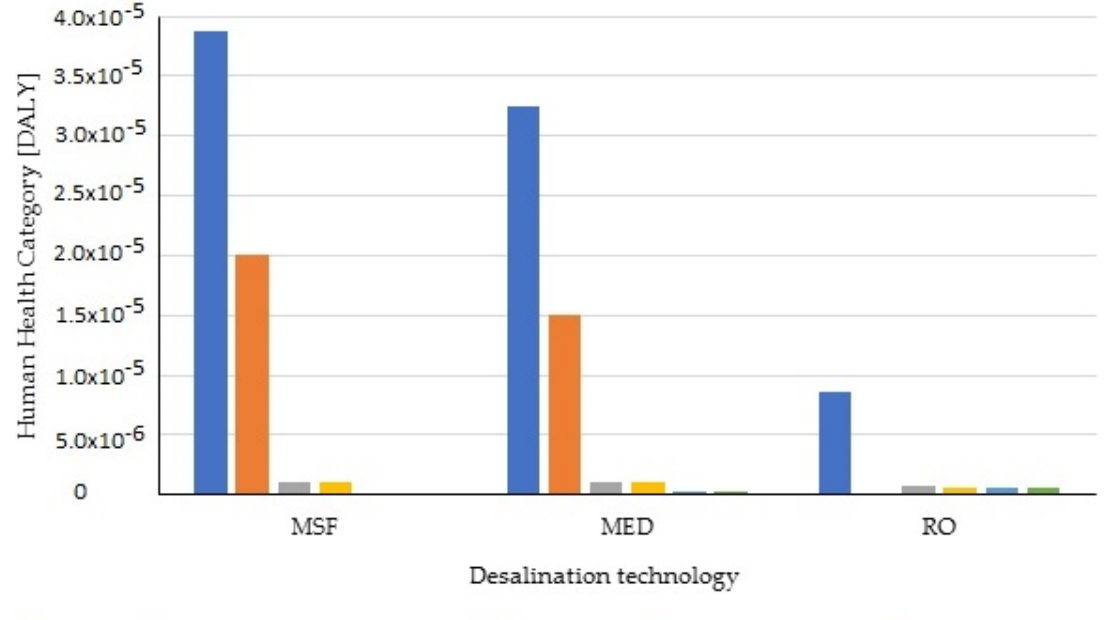
Figure 13. Comparison of desalination technologies used with different energy sources with the human health category based on the ReCiPe 2016 method.